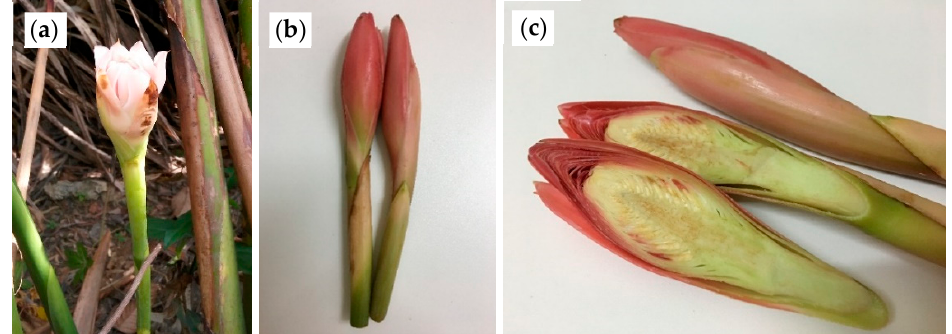
Figure 7. ( a ) Half-bloom inflorescence of E. elatior , ( b ) young shoots of E. elatior and ( c ) cross-section of the E. elatior flower.